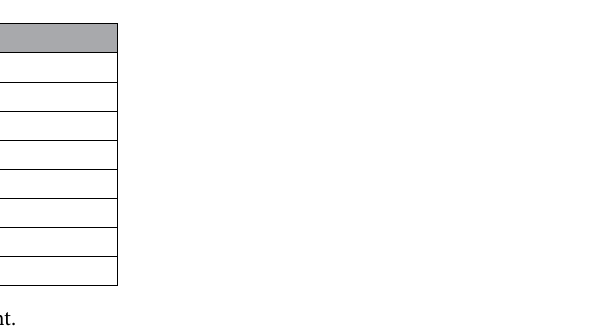
Table 1. Parameters used in the